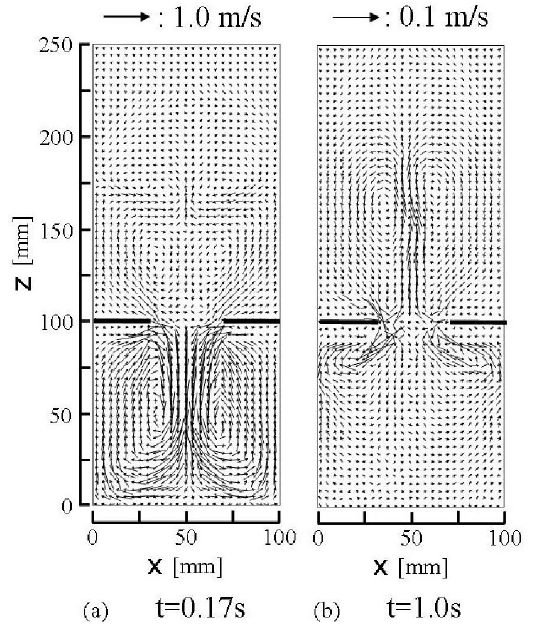
Figure 10. Calculated air velocity vector diagrams in the presence of air in the center cross-section of the computational domain y = 2.5 mm. The point of the arrow head and the length of the arrow indicate the position in the flow field and the size of the velocity vector, respectively.